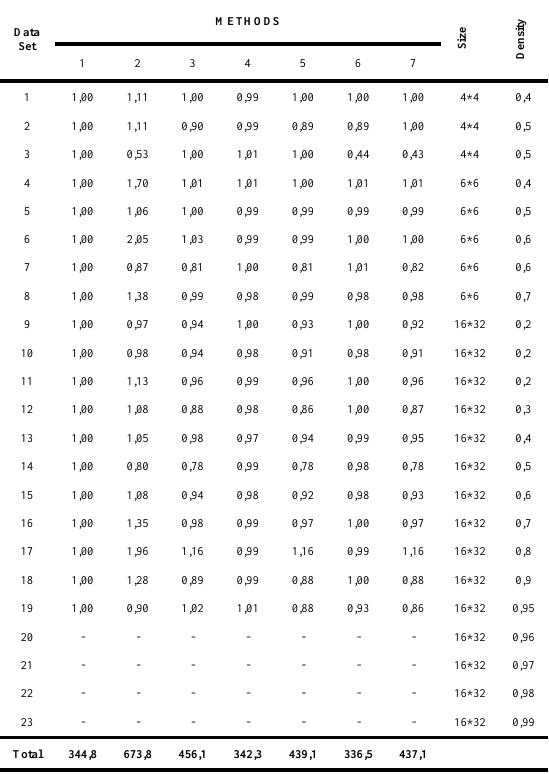
Table 6. Relative comparison of solution times